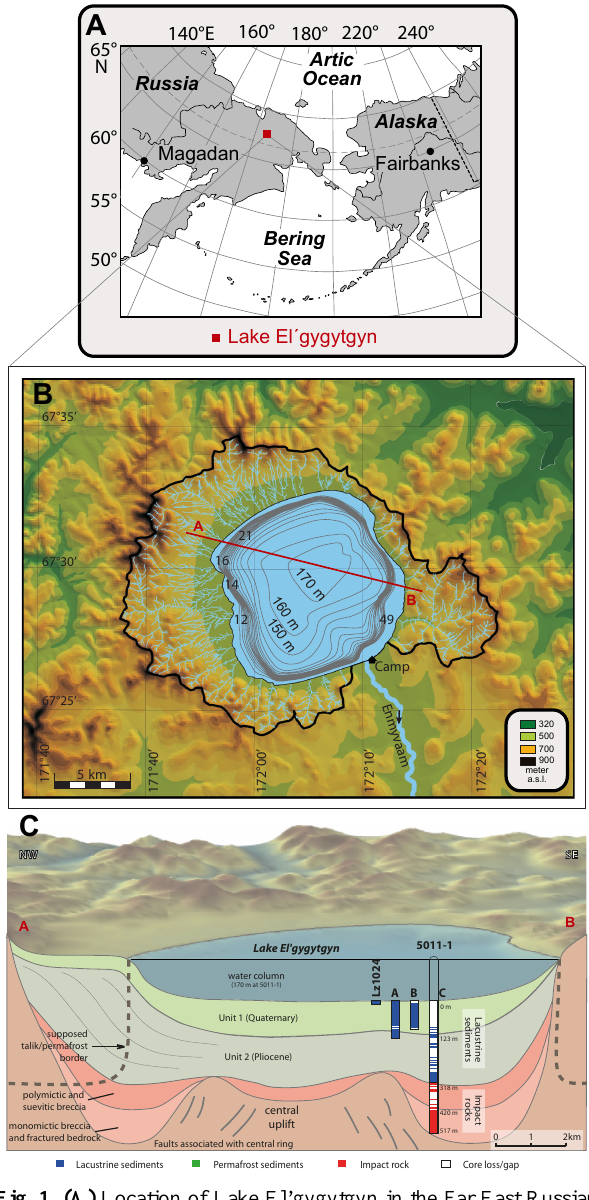
Fig. 1. (A) Location of Lake El’gygytgyn in the Far East Russian Artic; (B) bathymetric map of the lake and topographic map of the catchment area, including the approximately 50 inlet streams and the Enmyvaam River outlet (Fedorov and Kupolov, 2005); red line: profile A to B. (C) Schematic profile A to B with the locations of the pilot core Lz 1024 and the three holes (A, B and C) at ICDP site 5011-1 with the Pliocene–Pleistocene boundary penetrated at ap- proximately 123m, and the transition to the impact breccia at 318m below lake floor (modified after Melles et al.,